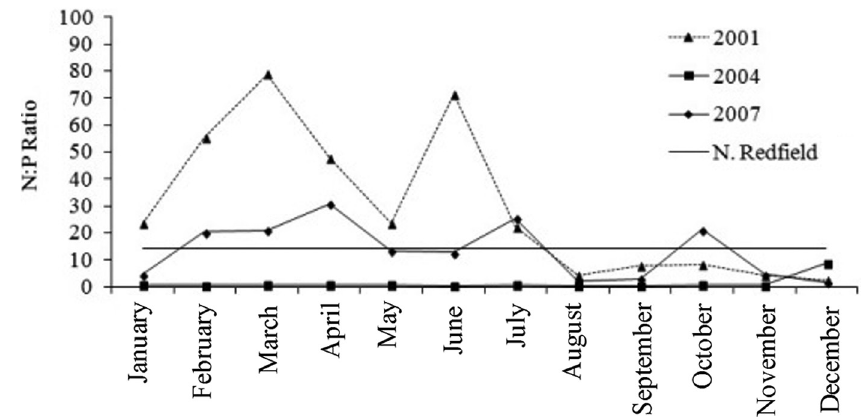
Figure 7. Monthly variability of N:P ratio during the three hydrological